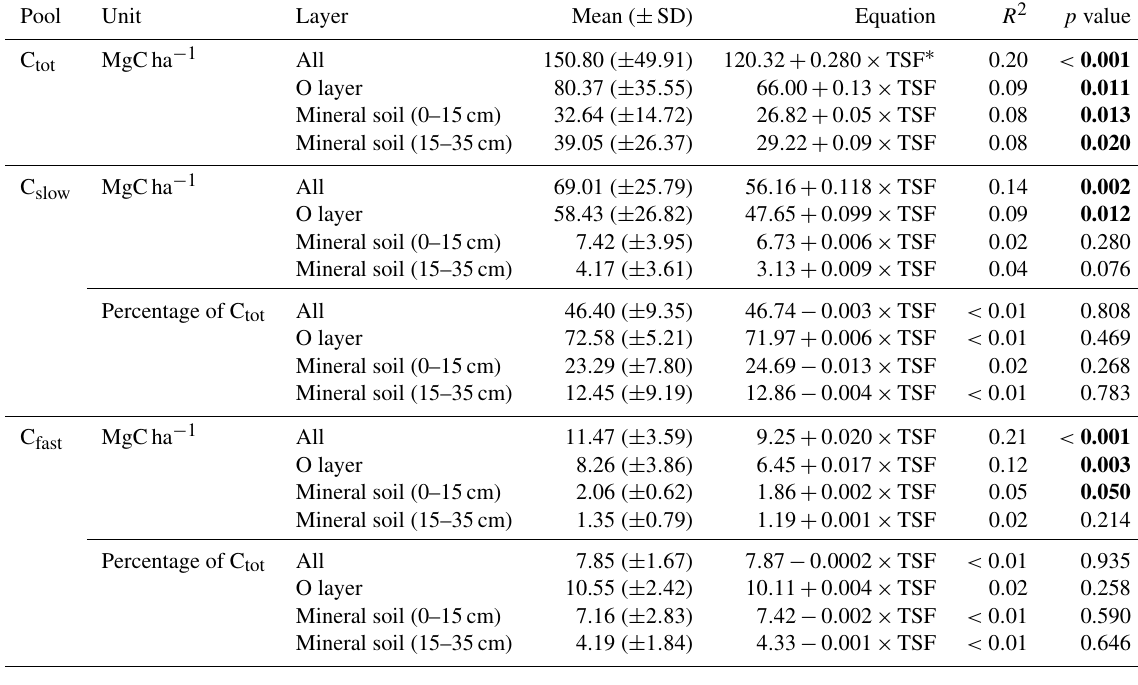
Table 2. Post-fire soil C pool size and accumulation rates.